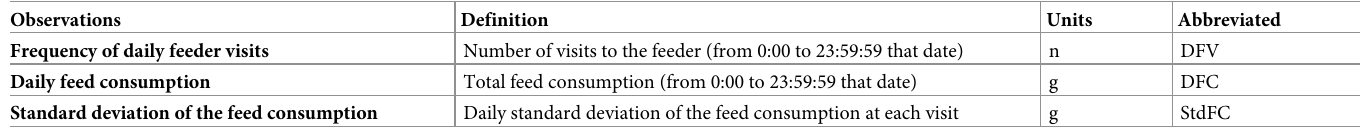
Table 1. Observations used for tail biting